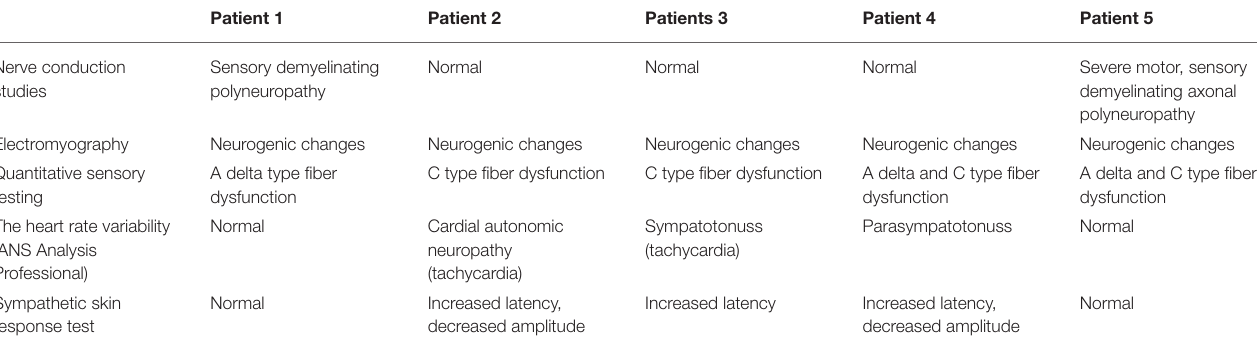
TABLE 4 | Neurophysiological findings.